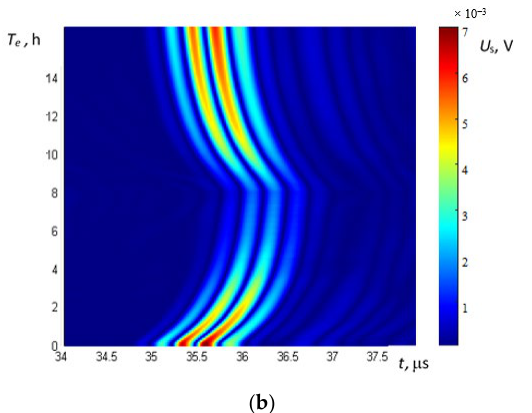
Figure 9. The recorded ultrasonic signals at different temperatures: ( a ) reverberations after excitation of the transducer and reflected signals; ( b ) zoomed-in view of the B-scan.